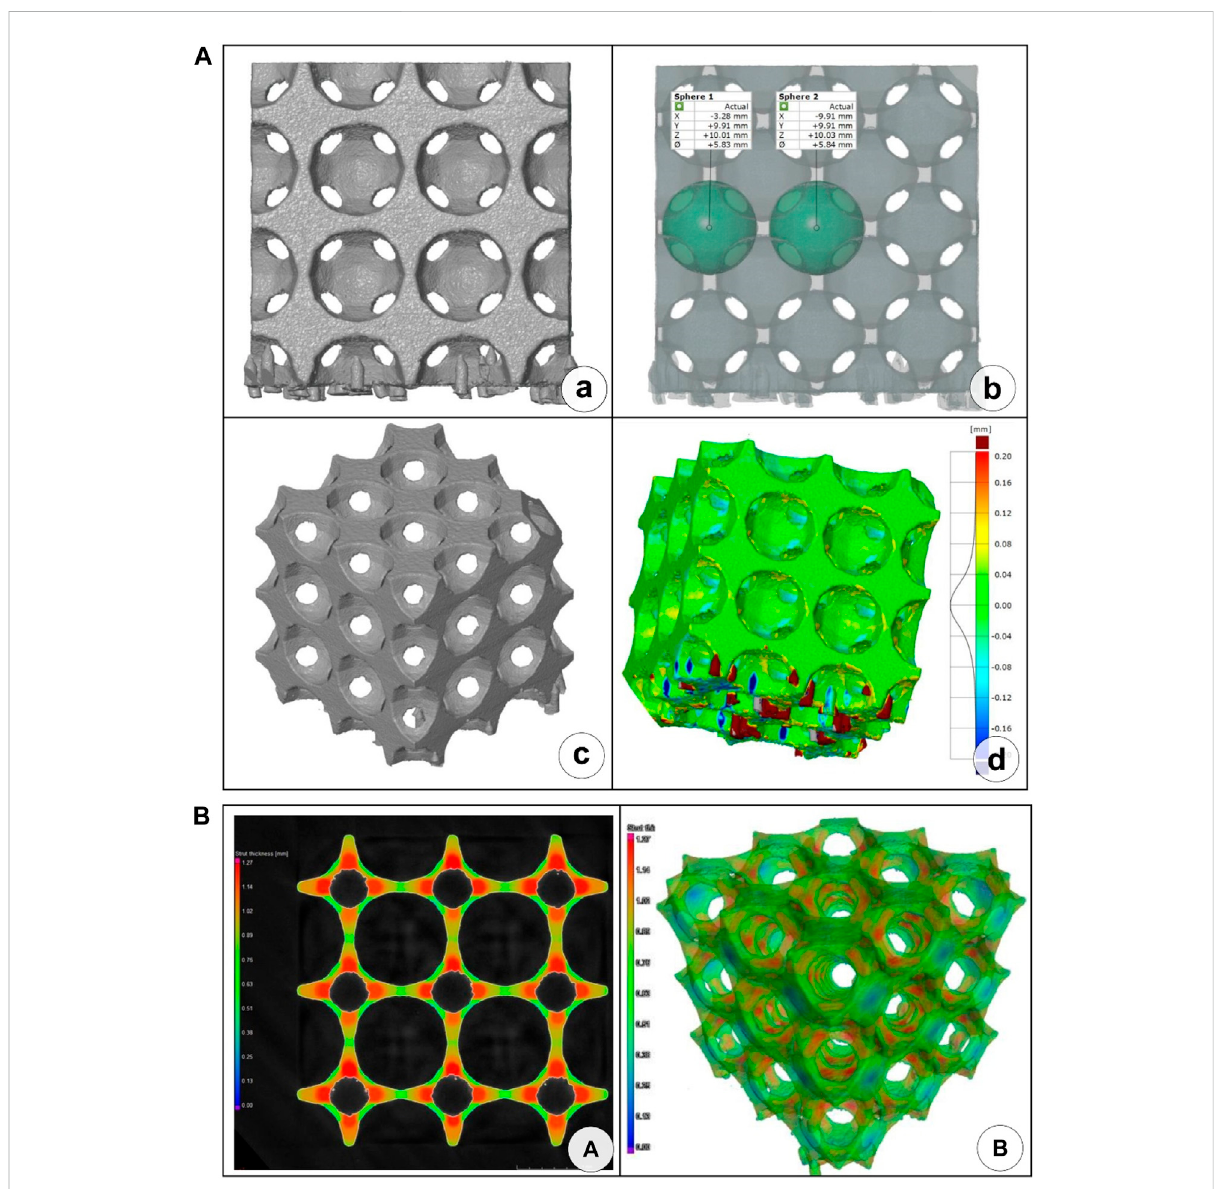
FIGURE 18 CTreconstructionofspecimenno.3. (A) frontviewofCT-reconstructedmodel; (B) measurementofcut-outspherediameter; (C) axonometric view of CT-reconstructed model; (D) geometric mismatch between the 3D model and the printed specimens (calculated with Geometry software); (E) cell wall thickness dimensions in 2D section; (F) cell wall thickness dimensions in 3D reconstructed model.